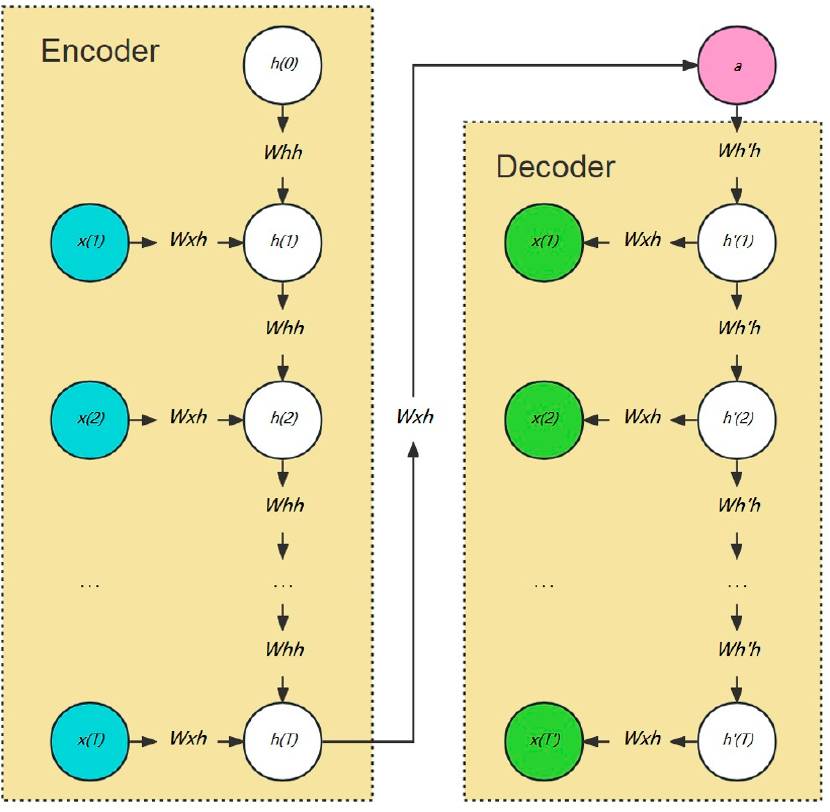
Figure 3. The architecture of the autoencoder built in this paper.